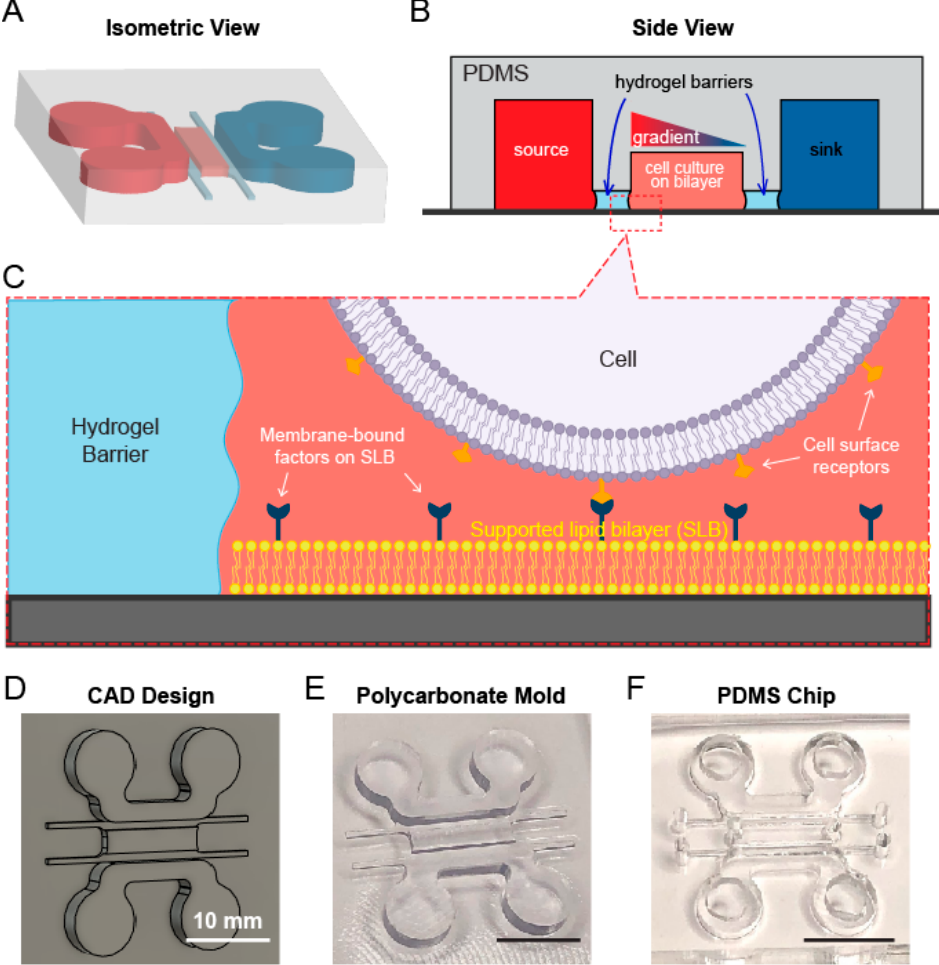
Figure 1. Design of a microchannel diffusion device for chemotactic studies . ( A ) An isometric view of the device design. ( B ) Schematics of the cross section of microchannels. ( C ) A zoomed-in illustration of cell culture chamber. ( D ) CAD design of the PC mold. ( E ) A micro-milled PC mold. ( F ) A PDMS device replica-molded from the PC mold and drilled with inlets and outlets.